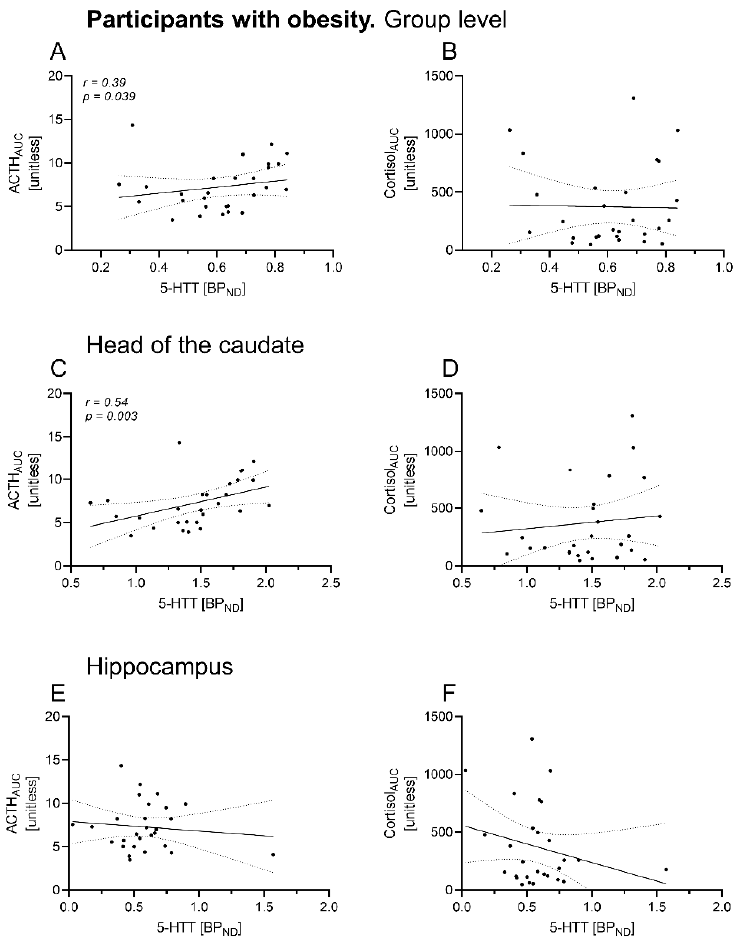
Figure 2. Association of 5-HTT BP ND with HPA axis responsiveness in dedicated brain areas in participants with obesity. Spearman correlation of 5-HTT BP ND of dedicated brain areas with hypothalamic–pituitary–adrenal (HPA) responsiveness in the obesity group. ACTH and cortisol AUC were derived from the dex/CRH test (unitless). Significant positive associations were found for 5-HTT BP ND on group level (( A ), averaged) and for the caudate nucleus with ACTH AUC ( C ), but not for the hippocampus ( E ). Cortisol AUC did not correlate significantly to 5-HTT binding potential ( B , D , F ). Dots indicate individual 5-HTT BP ND and HPA axis hormone values of the participants. Data are given with regression line and 95% confidence interval. dex, dexamethasone; CRH, corticotropin- releasing hormone; ACTH, adrenocorticotropic hormone, AUC, area under the